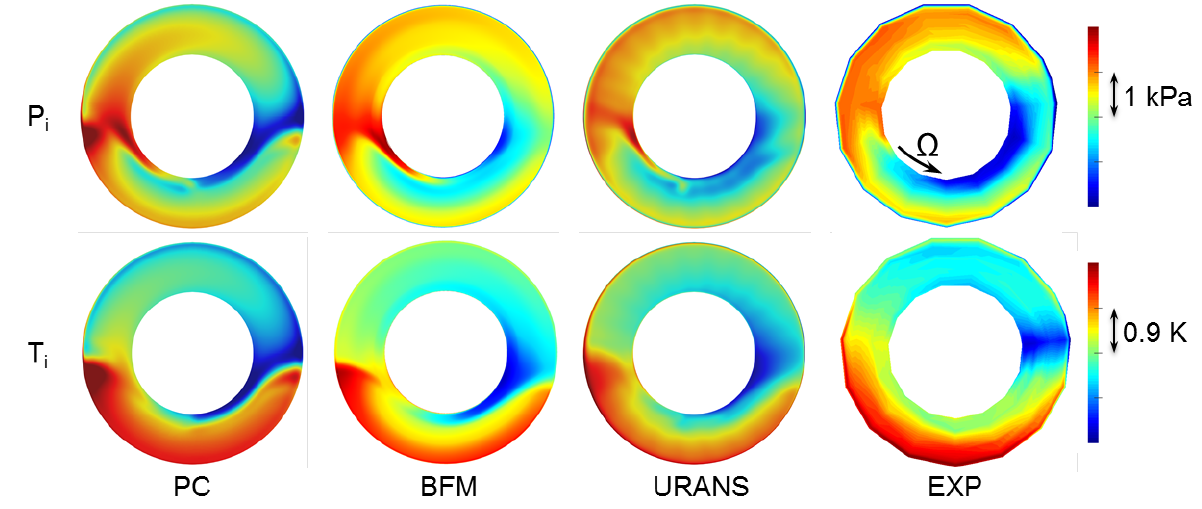
Figure 11. Total pressure ( top ) and total temperature ( bottom ) downstream of the